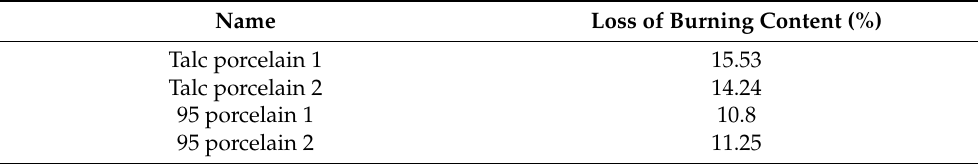
Table 4. Waxing results of special